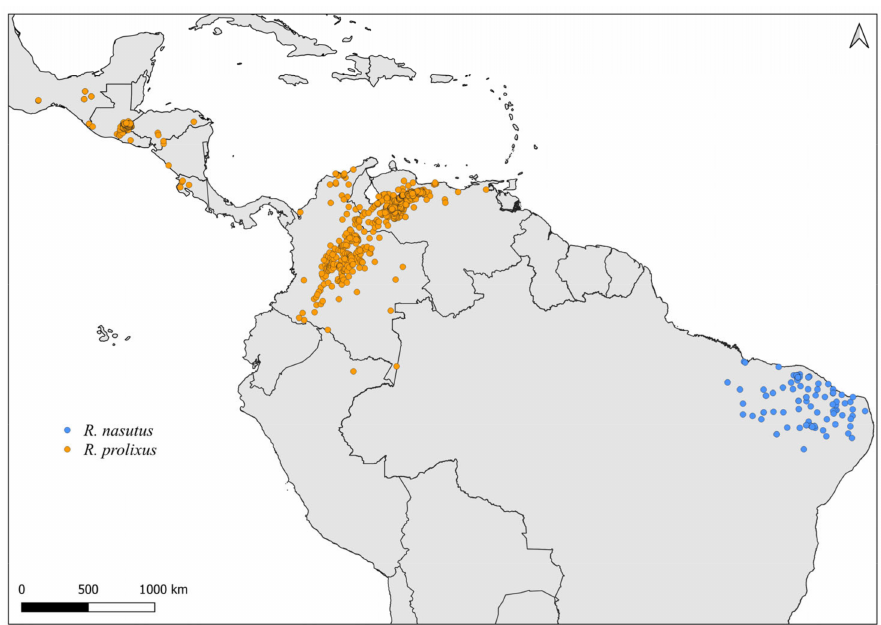
Figure 8. Distribution maps for R. nasutus and R. prolixus